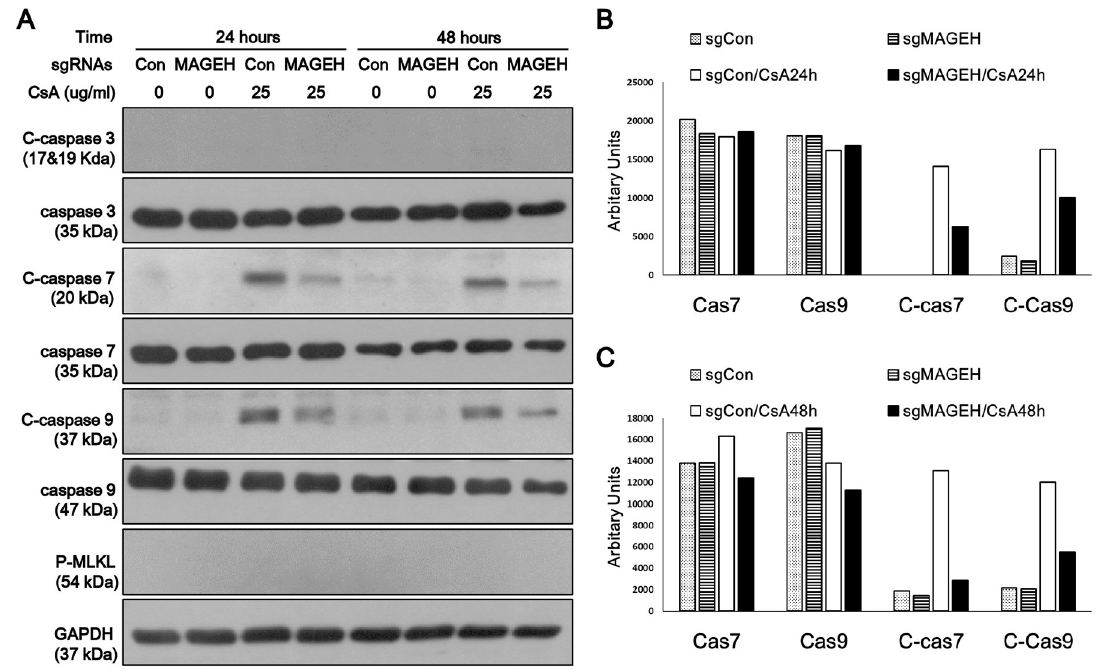
Fig 10. Western blot analysis of caspase activation in HRE cells: Effect of silencing of MAGEH1. sgMAGEH and sgCon HRE stable cells were incubated with 25 μ g/ml CSA for 24 and 48 hours to harvest protein for western blotting (A) . Quantification of western blots (caspase 7, caspase 9, C-caspase 7, C-caspase 9) was performed using Image J at 24 hours (B) , and 48 hours of incubation with CsA (C) . C-caspases represent cleaved (active)-caspases; sgRNA MAGEH, single guide RNA constructs to knockdown MAGEH1; sgRNA Con, control single guide RNA constructs targeting no known